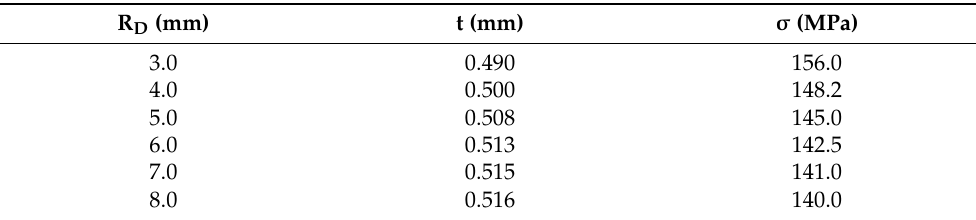
Table 3. The thickness and stress results at point F with different values of die edge radius.